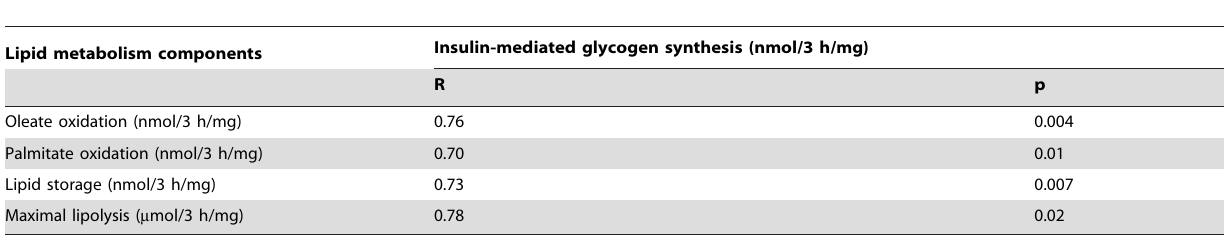
Table 3. Correlations between changes in components of lipid metabolism and changes in insulin responsiveness during activation of cAMP/PKA and calcium signaling pathways in cultured human myotubes.